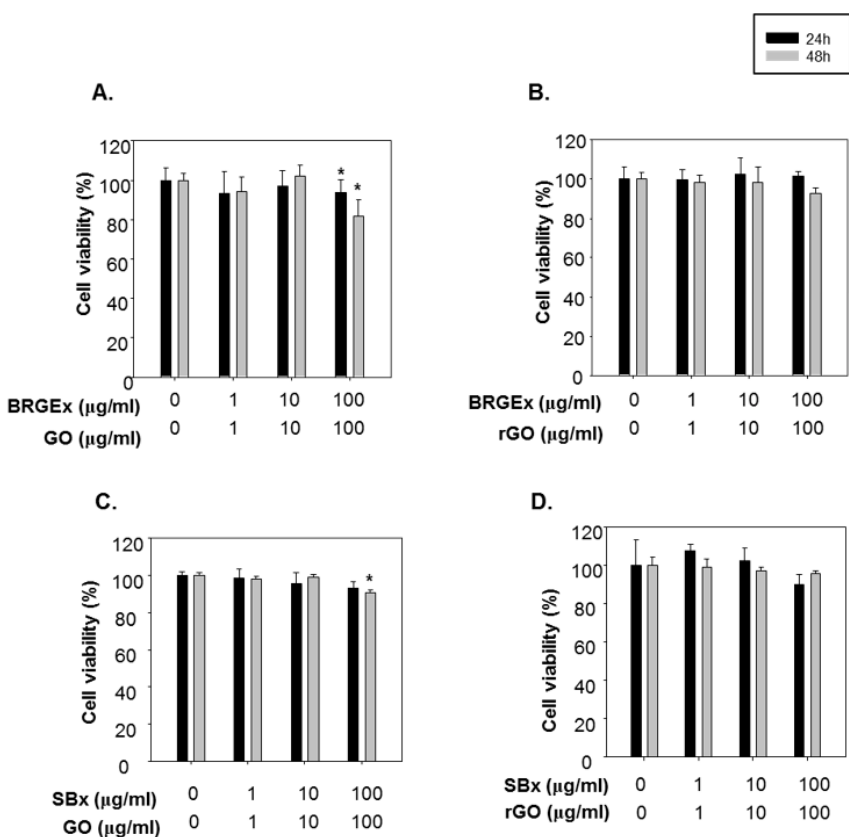
Figure 2. Effect of co-treatment of graphene oxide (GO) or reduced graphene oxide (rGO) with colored grain extract on cell viabilities in B3 cells. B3 cells were co-treated with ( A ) BRGE extract (BRGEx) and GO, ( B ) BRGE extract (BRGEx) and rGO, ( C ) soybean extract (SBx) and GO, ( D ) soybean extract (SBx) and rGO at the indicated dose for 24 h (black bar) or 48 h (gray bar), and then cell viabilities were determined using an MTT assay. * p < 0.05 vs. vehicle-treated cells.